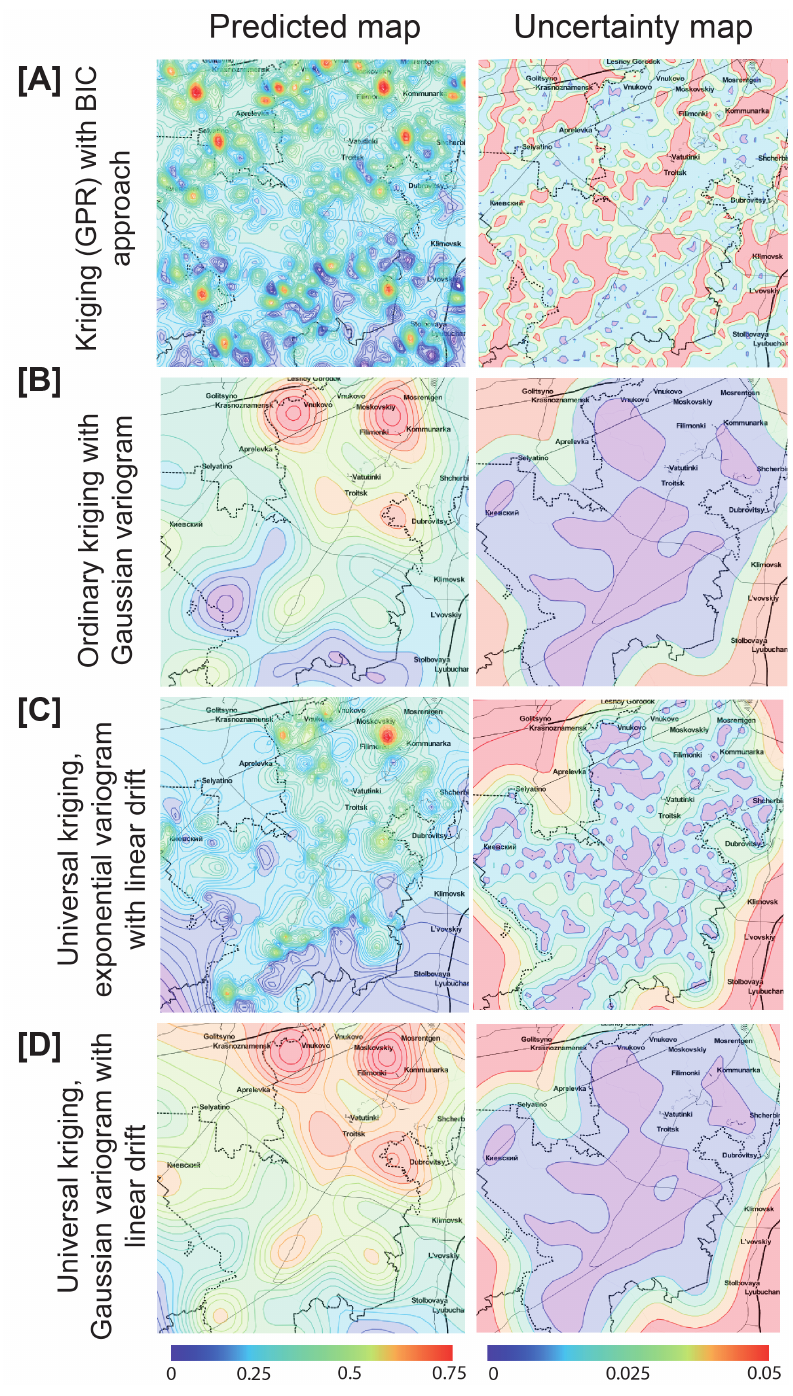
Figure 6. Geospatial prediction of Water quality index and uncertainty maps based on differ- ent techniques: ( A )—GPR coupled with BIC; ( B )—Ordinary kriging with Gaussian variogram; ( C )—Universal kriging, Exponential variogram + linear drift; ( D )—Universal kriging, Gaussian variogramm + linear